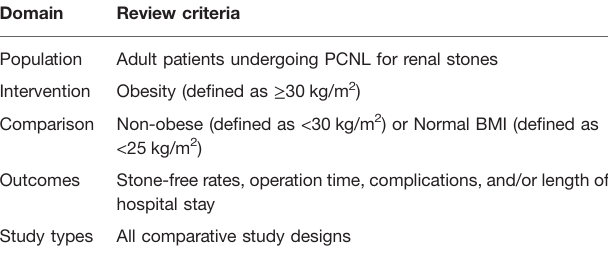
Stone-free rates, operation time, complications, and/or length of hospital stay Study types All comparative study designs BMI, body mass index; PCNL, percutaneous